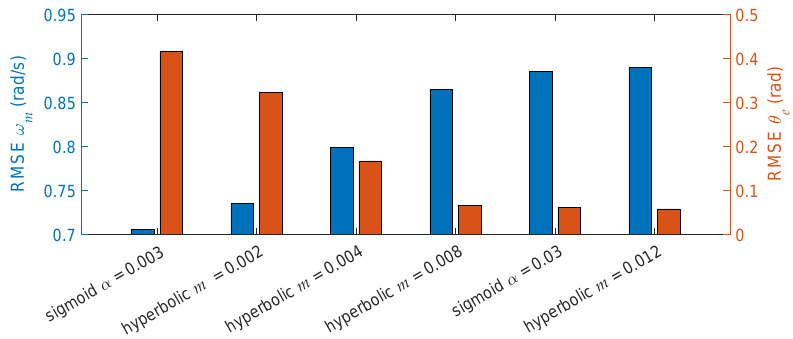
Figure 8. RMSE ω m and RMSE θ e values of the Pareto optimal solutions from Figure 7.